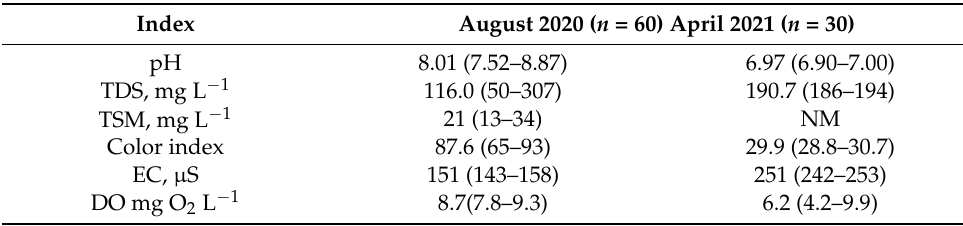
Table 1. Physico-chemical parameters of the Ob River